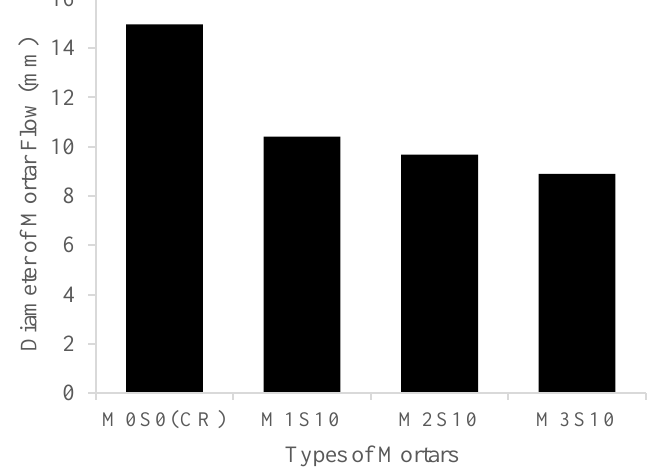
Figure 7. Effects of SDPMF content and 10% SF on the workability.